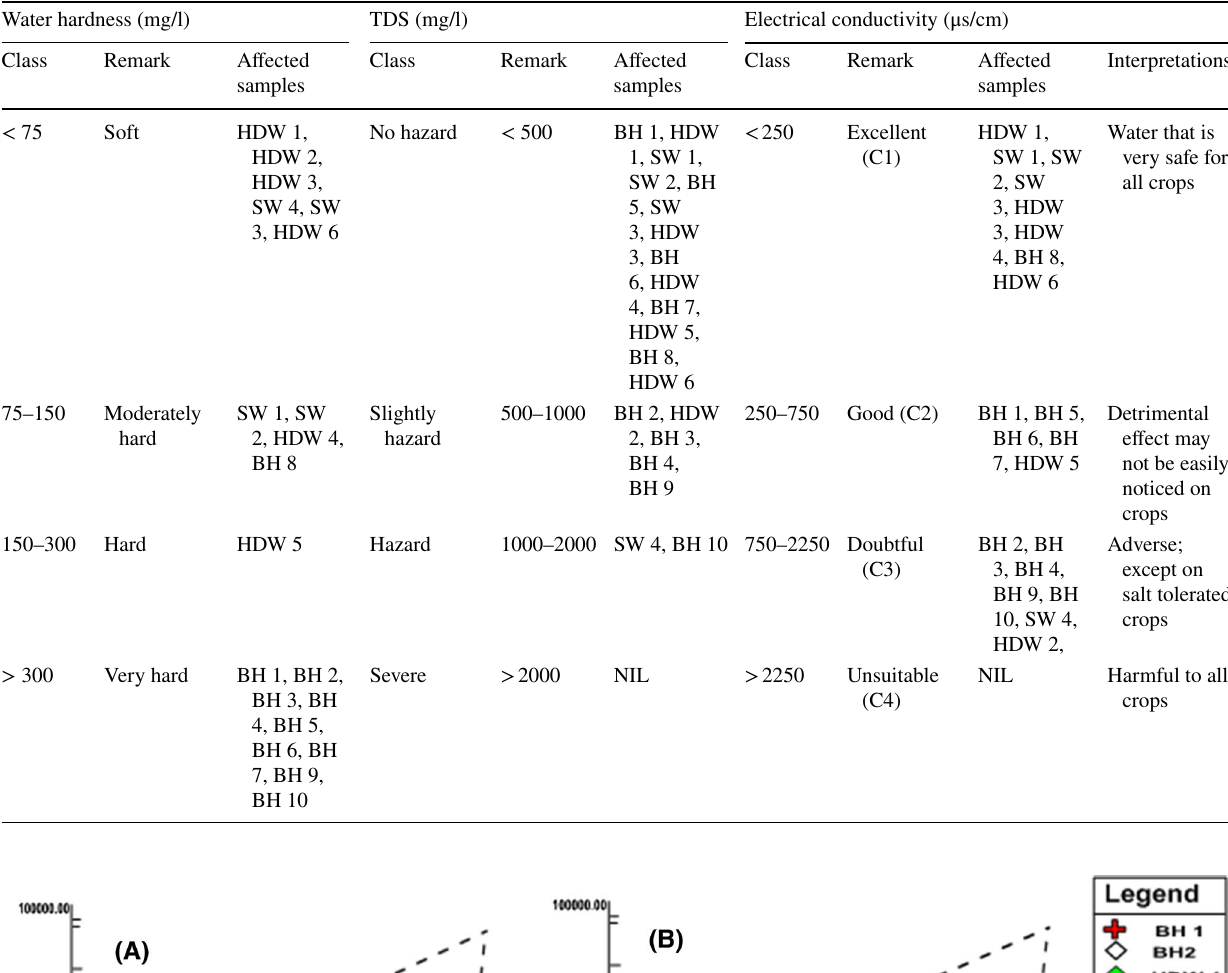
Table 4 Classification of hardness, EC, TDS and the affected samples Water hardness (mg/l)